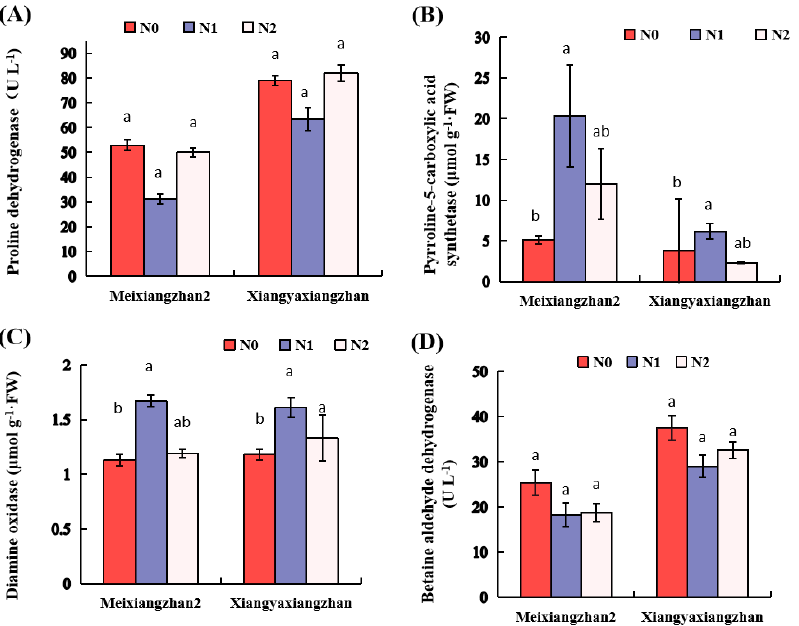
Figure 5. Effects of N on the activities of ( A ) proline dehydrogenase (PRODH), ( B ) Δ 1-pyrroline-5- carboxylate synthetase (P5CS), ( C ) diamine oxidase (DAO) and ( D ) betaine aldehyde dehydrogenase2 (BADH2) in both fragrant rice cultivars. Data are means (±SE), n = 3. The different letter above the column indicates difference at p < 0.05 by LSD tests. Capped bars represent standard errors.